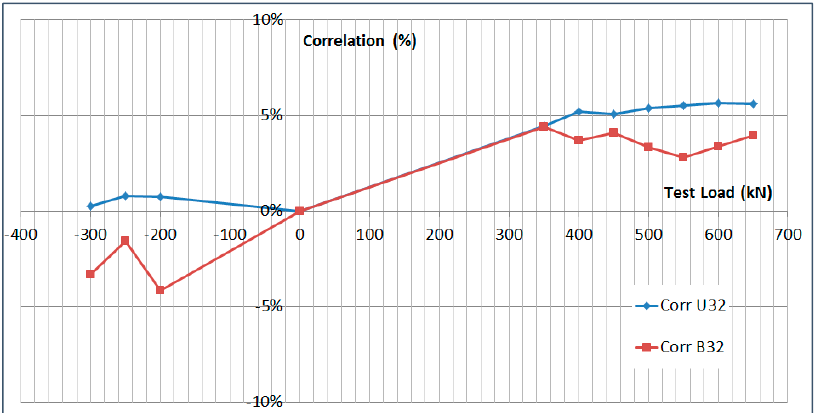
Figure 17. Limit Load Test Data Comparison.